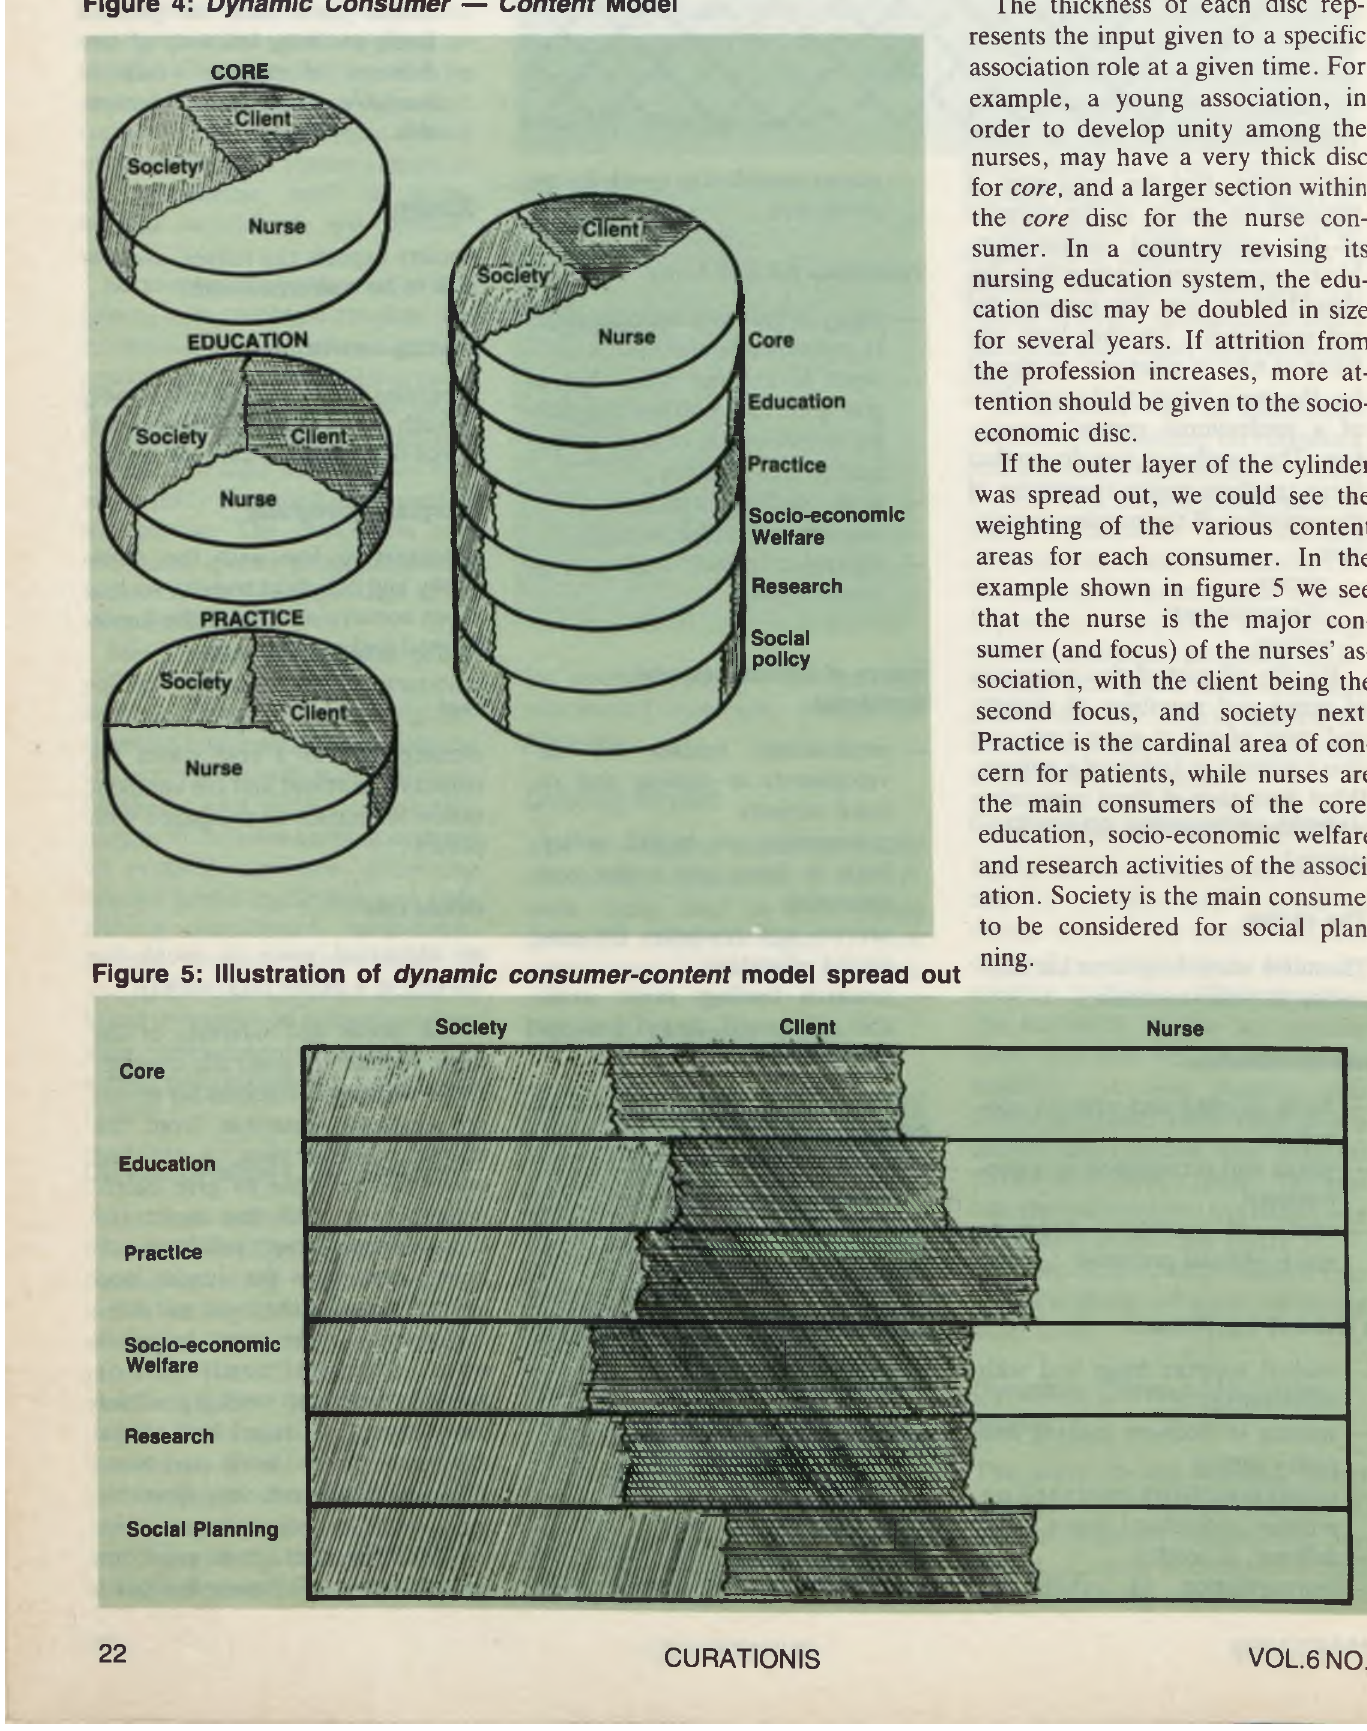
Figure 4: Dynamic Consumer — Content Model